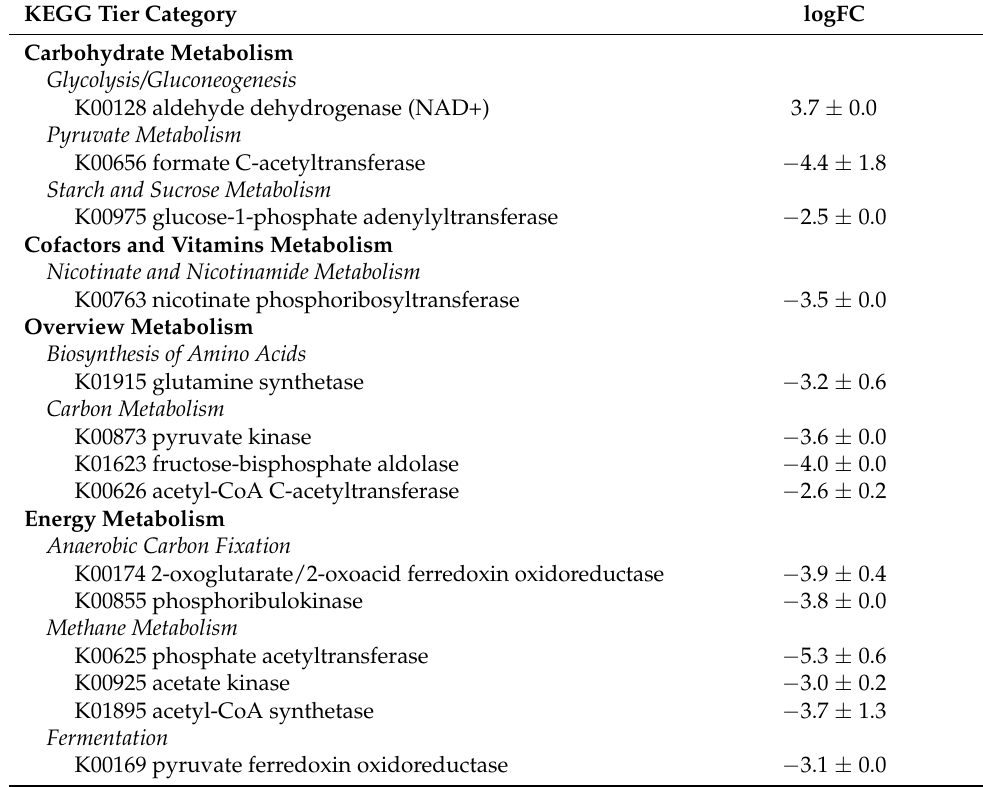
Table 4. Differential gene expression (DGE) for oxygen-regulated KEGG orthologs (KOs). Each KO represents an oxygen-regulated gene and was included based on DGE significance within Tussock T4 vs. T0 sampling period (FDR < 0.05; Dataset S5), where a positive log-fold change (logFC) value indicates higher expression at T4 relative to